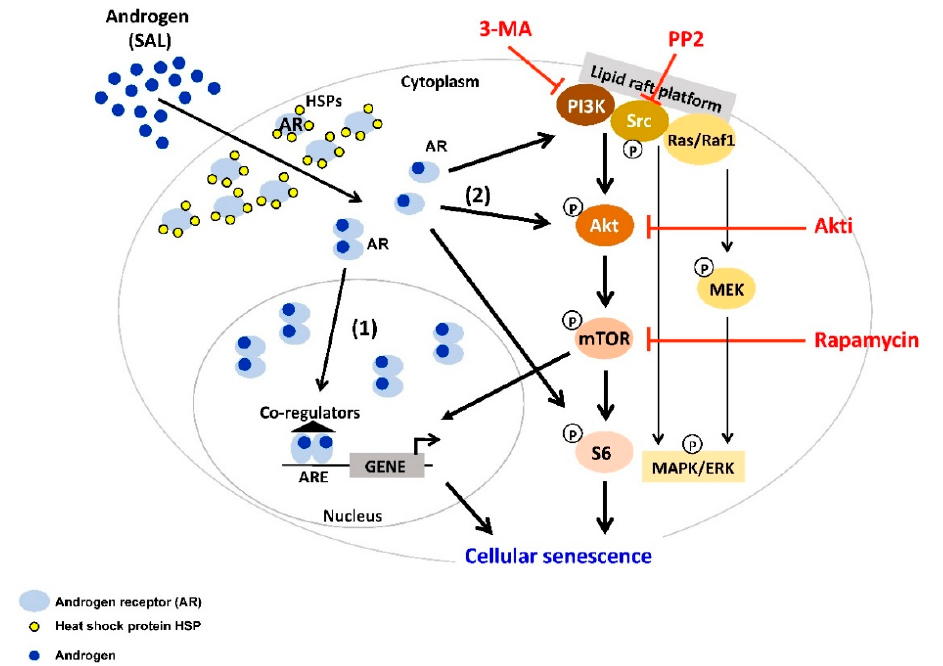
Figure 1. Androgen at supraphysiological level (SAL) induces cellular senescence through the PI3K/Src/Akt/mTOR pathway. In the cytoplasm, androgen receptor (AR) forms a complex with heat shock proteins (HSPs). Activation of the AR is triggered by binding of androgens (AR agonist) to the receptor. Androgen ‐ activated AR dissociates from HSPs, and subsequently mediates AR signaling. (1) The majority of activated AR forms homodimer and translocates into the nucleus, where it binds to androgen response element (ARE) at the promoter of the target genes and mediates transcription. (2) A minor fraction of activated AR remains in the cytoplasm, interacts with and functions through several signaling molecules, e.g., Src, PI3K/Akt, S6, Ras/Raf1, MAPK/ERK. Interestingly, co ‐ treatment of SAL with inhibitors of PI3K (3 ‐ MA), Src family members (PP2), Akt (Akti), or mTOR (Rapamycin) inhibits senescence induction. This indicates that Src/PI3K/Akt/mTOR pathway is involved in SAL ‐ mediated cellular senescence in PCa cells.